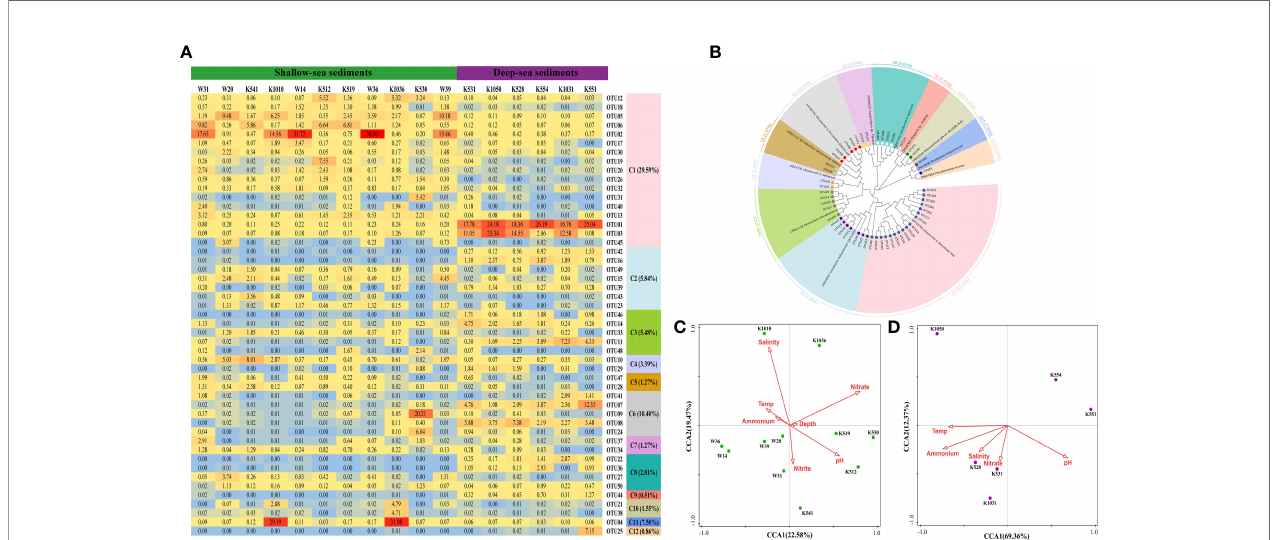
FIGURE 4 | Microbial characteristics of the nos Z I gene in surface sediments of the northern SCS. (A) The heat map of dominant OTUs for the nos Z I gene (Top 50 OTUs). (B) Neighbor-joining phylogenetic tree of dominant OTUs (Top 50 OTUs) and the reference sequences from Genbank (bootstrap 1000). (C) The canonical correspondence analysis (CCA) for the nos Z I gene from shallow-sea surface sediments. (D) The canonical correspondence analysis (CCA) for the nos Z I gene from deep-sea surface